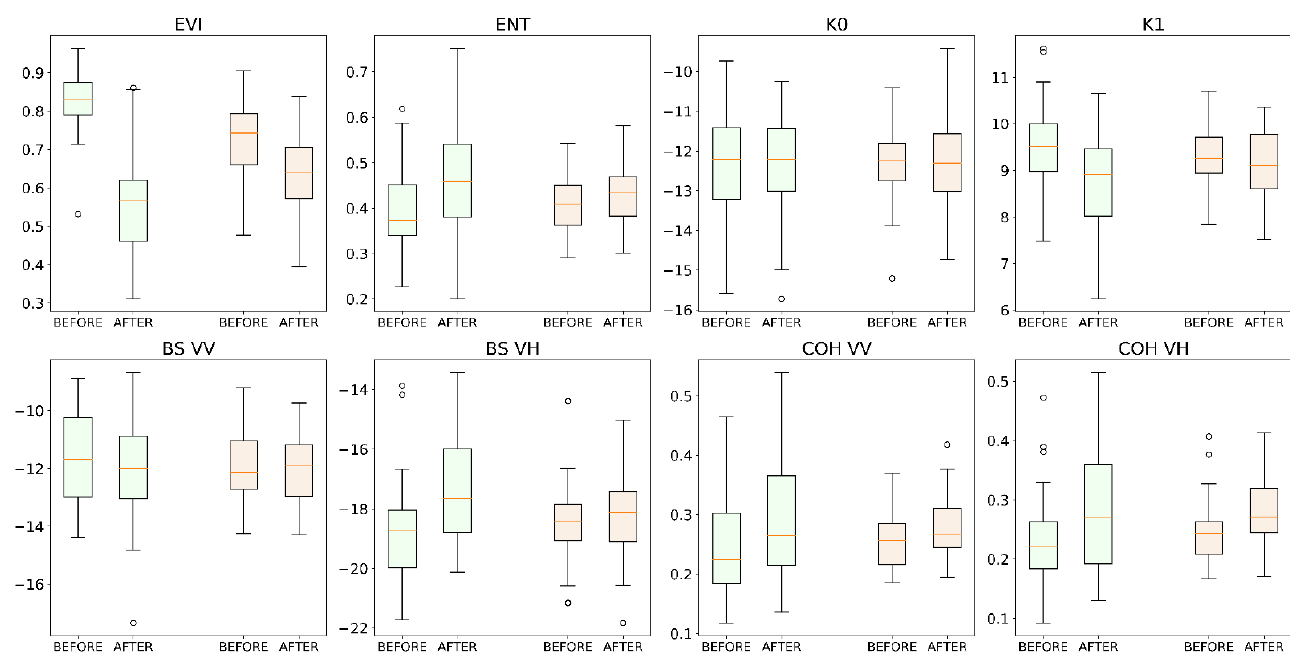
Figure 4. Data values of observed parameters for a period of six days before and six days after a mowing event for all mowing events (n = 45) of all 13 parametrization sites. Left: raw data (green boxes. Right: interpolated and smoothed data (orange boxes).